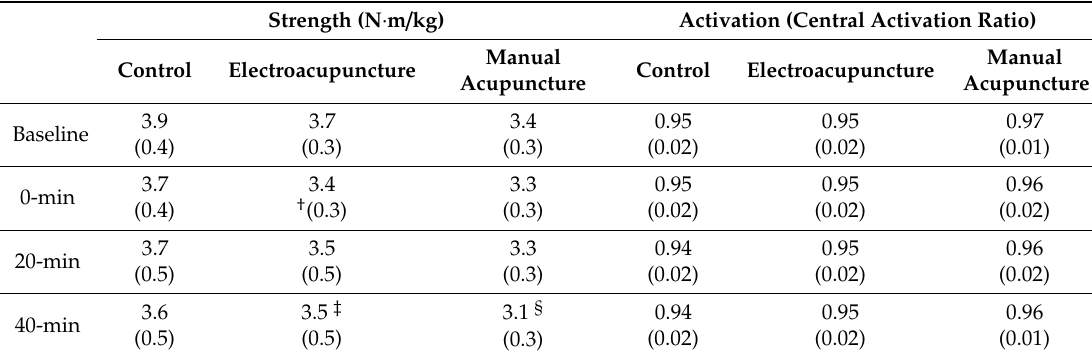
Table 5. Changes in quadriceps function. Values are mean (95% confidence